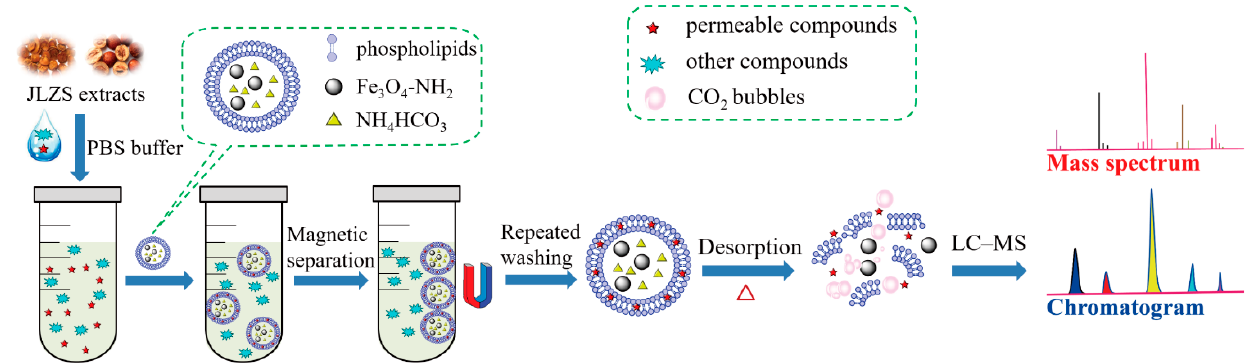
Figure 1. Schematic illustration of the proposed screening strategy using bubble-generating magnetic liposomes coupled with LC–MS.